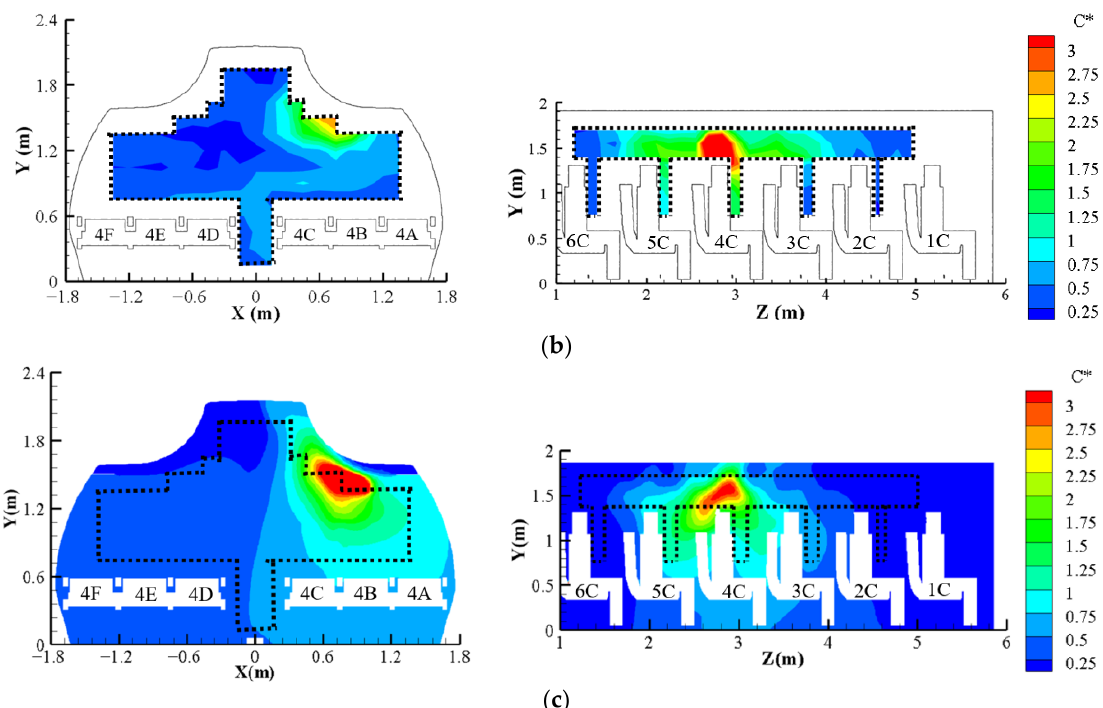
Figure 5. Validation of CFD model: ( a ) comparison of airflow field in a cross-section across the fourth row, ( b ) the steady-state concentration fields of dimensionless particle concentrations by measurement, ( c ) the steady-state concentration fields of dimensionless particle concentrations by CFD simulation.